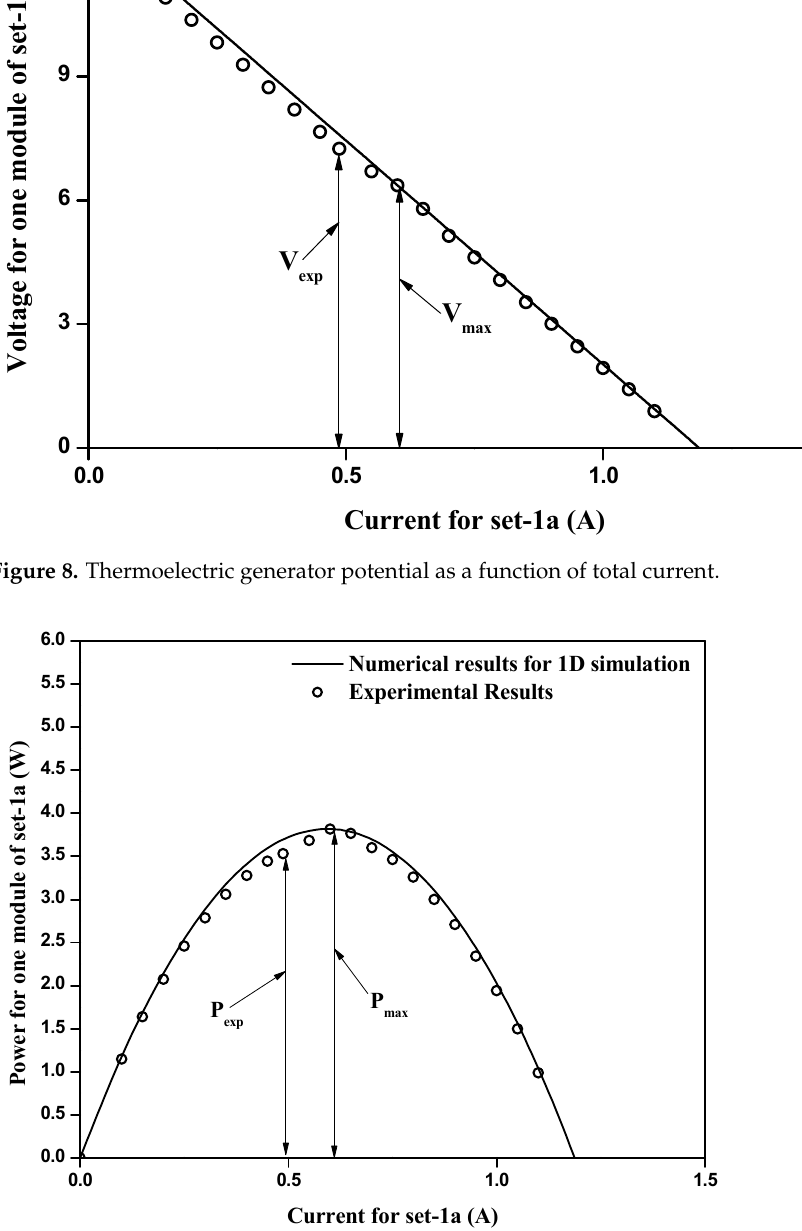
Figure 9. Thermoelectric generator power as a function of total current. An attempt was made to obtain the temperature variation across a TEG system in the longitudinal direction of the billet through numerical analysis (Figure 10). The largest temperature drop of 321.92 °C was observed between the billet surface temperature and billet-side absorber plate temperature. The radiation and free convection heat transfer took place between the billet and absorber plate. This may be the reason for the large temperature drop. In addition, heat transfer across the absorber plate and TEG layers took place through conduction, and the large temperature drop observed between the hot and cold layers of the TEG was 87.6 °C. This may be due to the fact that the thermal conductivities of semiconductors and air are less than 1% that of the thermal conductivity of the absorber plate (Table 2). This is expected to be the largest drop in temperature between the hot and cold layers of the TEG and is beneficial for higher power generation during waste heat recovery. -0.02 -0.01